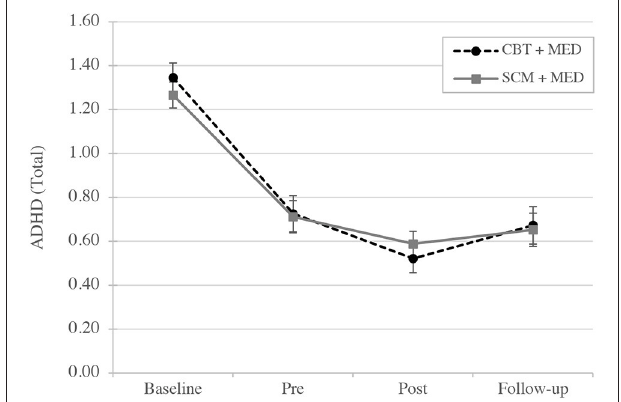
FIGURE 2 | Mean of latent variables: ADHD symptoms changes over time (baseline, pre, post, and follow-up evaluation). CBT, Cognitive-behavioral therapy; SCM, Standard clinical management; MED,